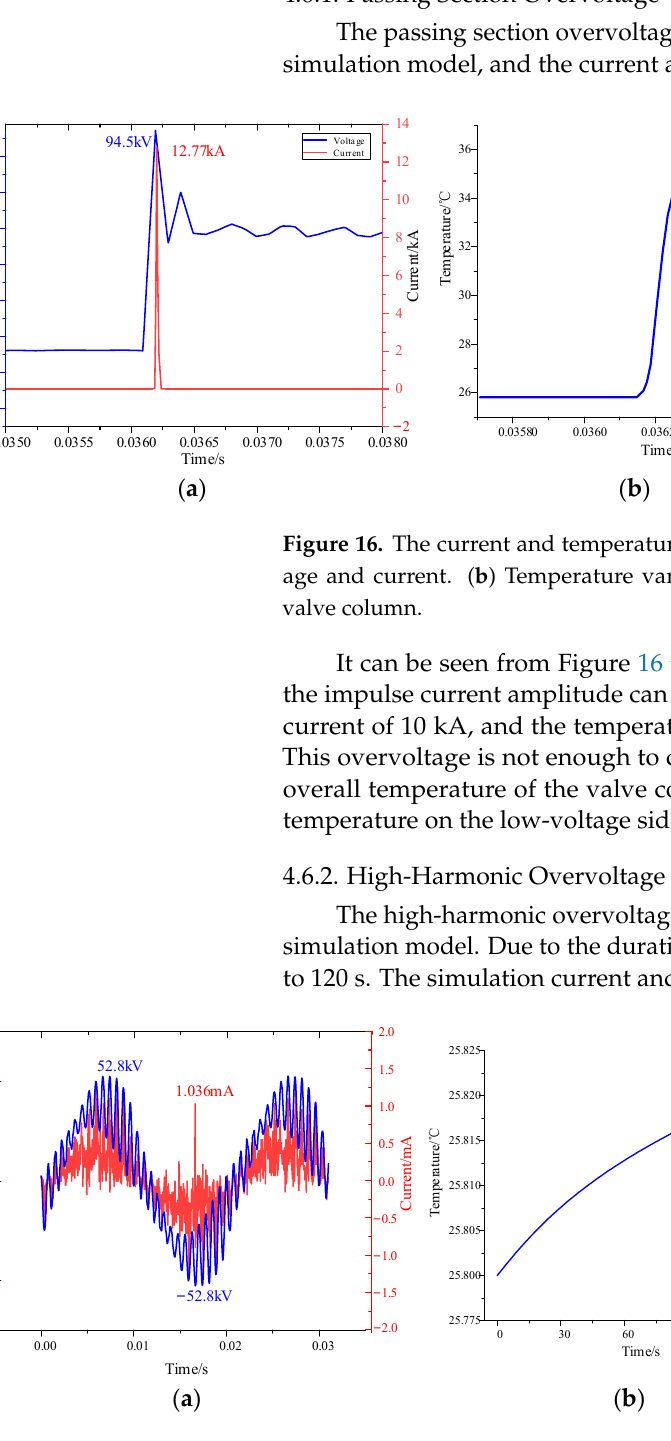
( c ) Figure 18. The current and temperature distribution of the arrester. ( a ) Steep impulse overvoltage and current. ( b ) Temperature variation of the arrester. ( c ) Temperature distribution of the valve column.